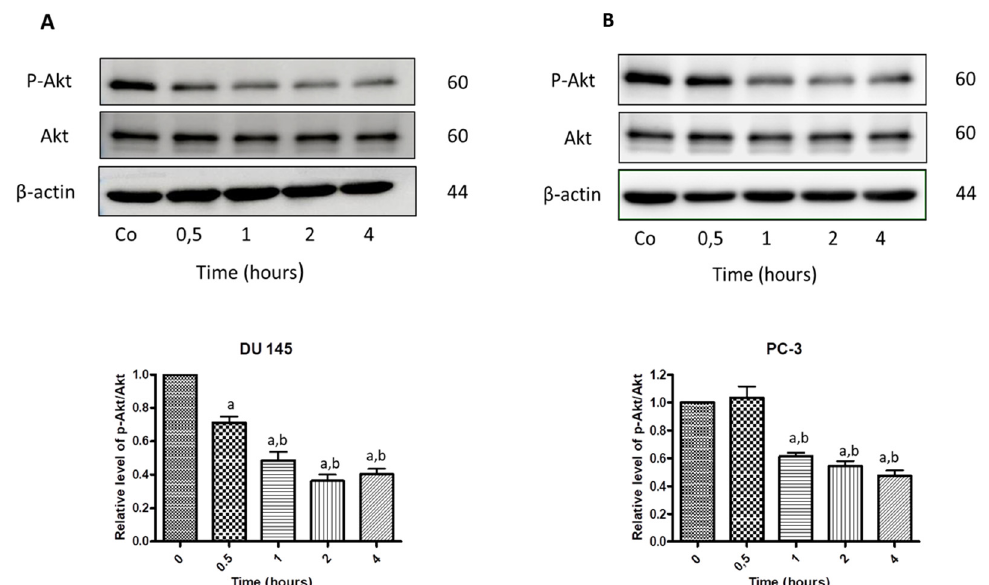
Figure 10. Western blot analysis of p-Akt and Akt kinase in DU145 ( A ) and PC-3 ( B ) cells treated with 40 μ M N -allyl-BS for indicated time points. β -actin was used as a lane loading control. Results are presented as mean ± SE (n = 3). The statistical significance of differences between respective samples was determined by one-way ANOVA followed by Bonferroni’s multiple comparison test, where (a) indicates significant difference between control and treated cells P < 0.01 and (b, c) indicates significant difference between 4, 8, and 24h of 40 μ M N -allyl-BS-treated cells P < 0.01.